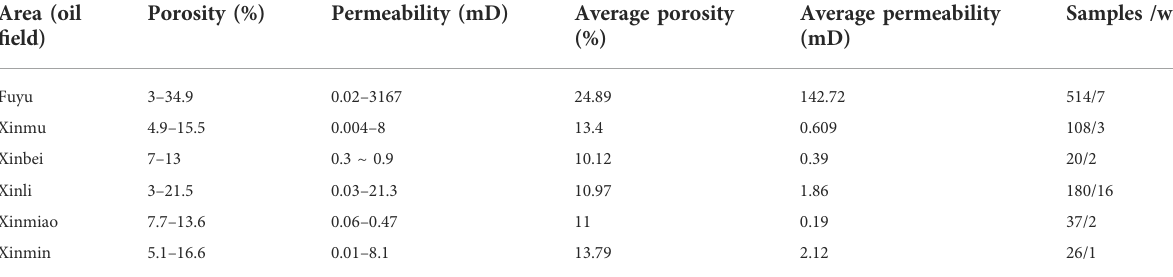
TABLE 1 Reservoir property of Quan 3 Member in different oil fi eld in the Fuxin Uplift.